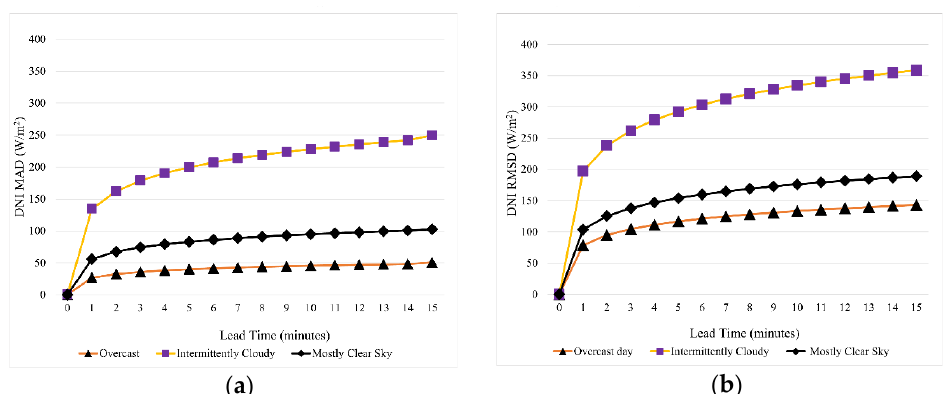
Figure 12. ( a ) DNI MADs for the 3 classes. ( b ) DNI RMSDs for the three classes.